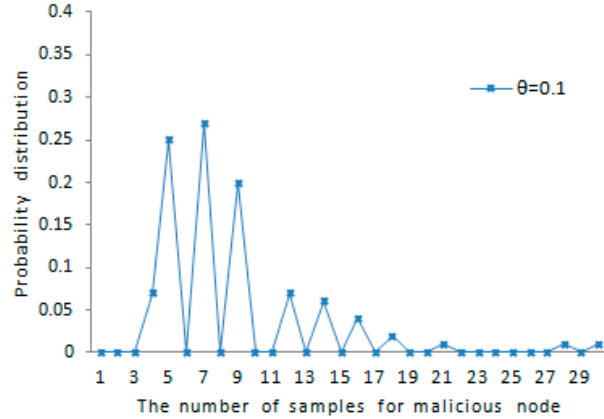
Sensors 2016 , 16 , 1955 Figure 7. The probability distribution of the amount of samples for malicious node.